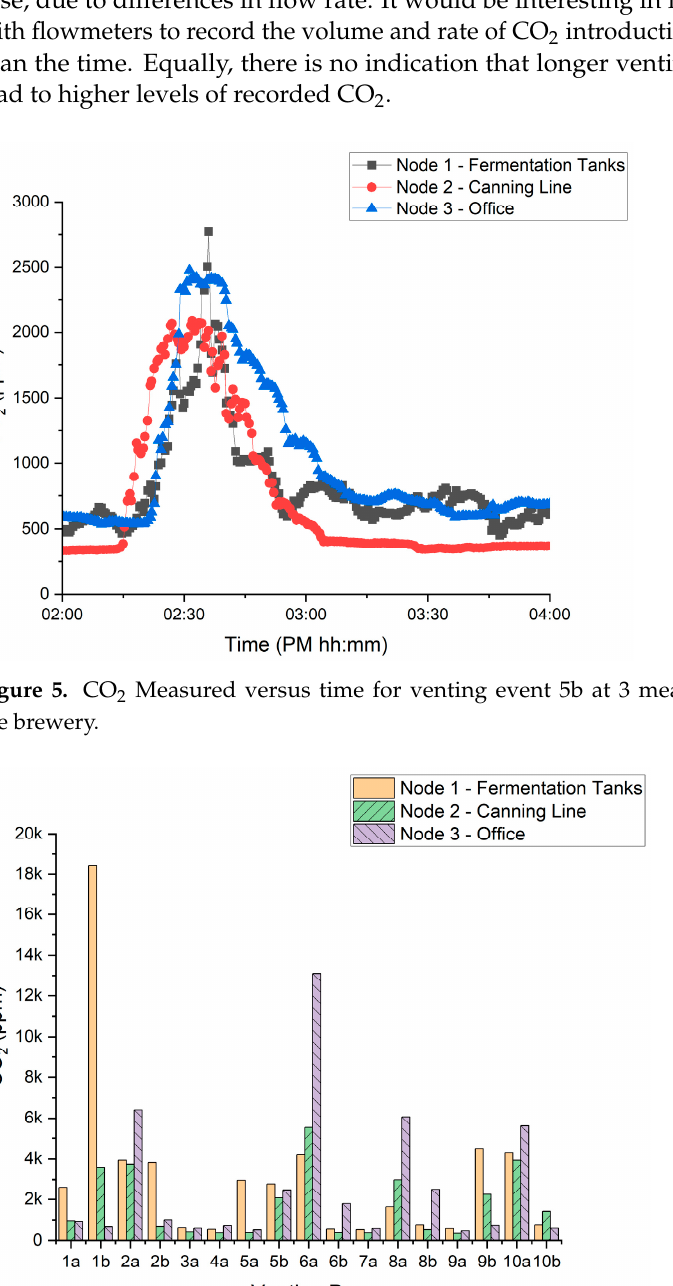
Figure 5. CO 2 Measured versus time for venting event 5b at 3 measurements locations within the brewery.